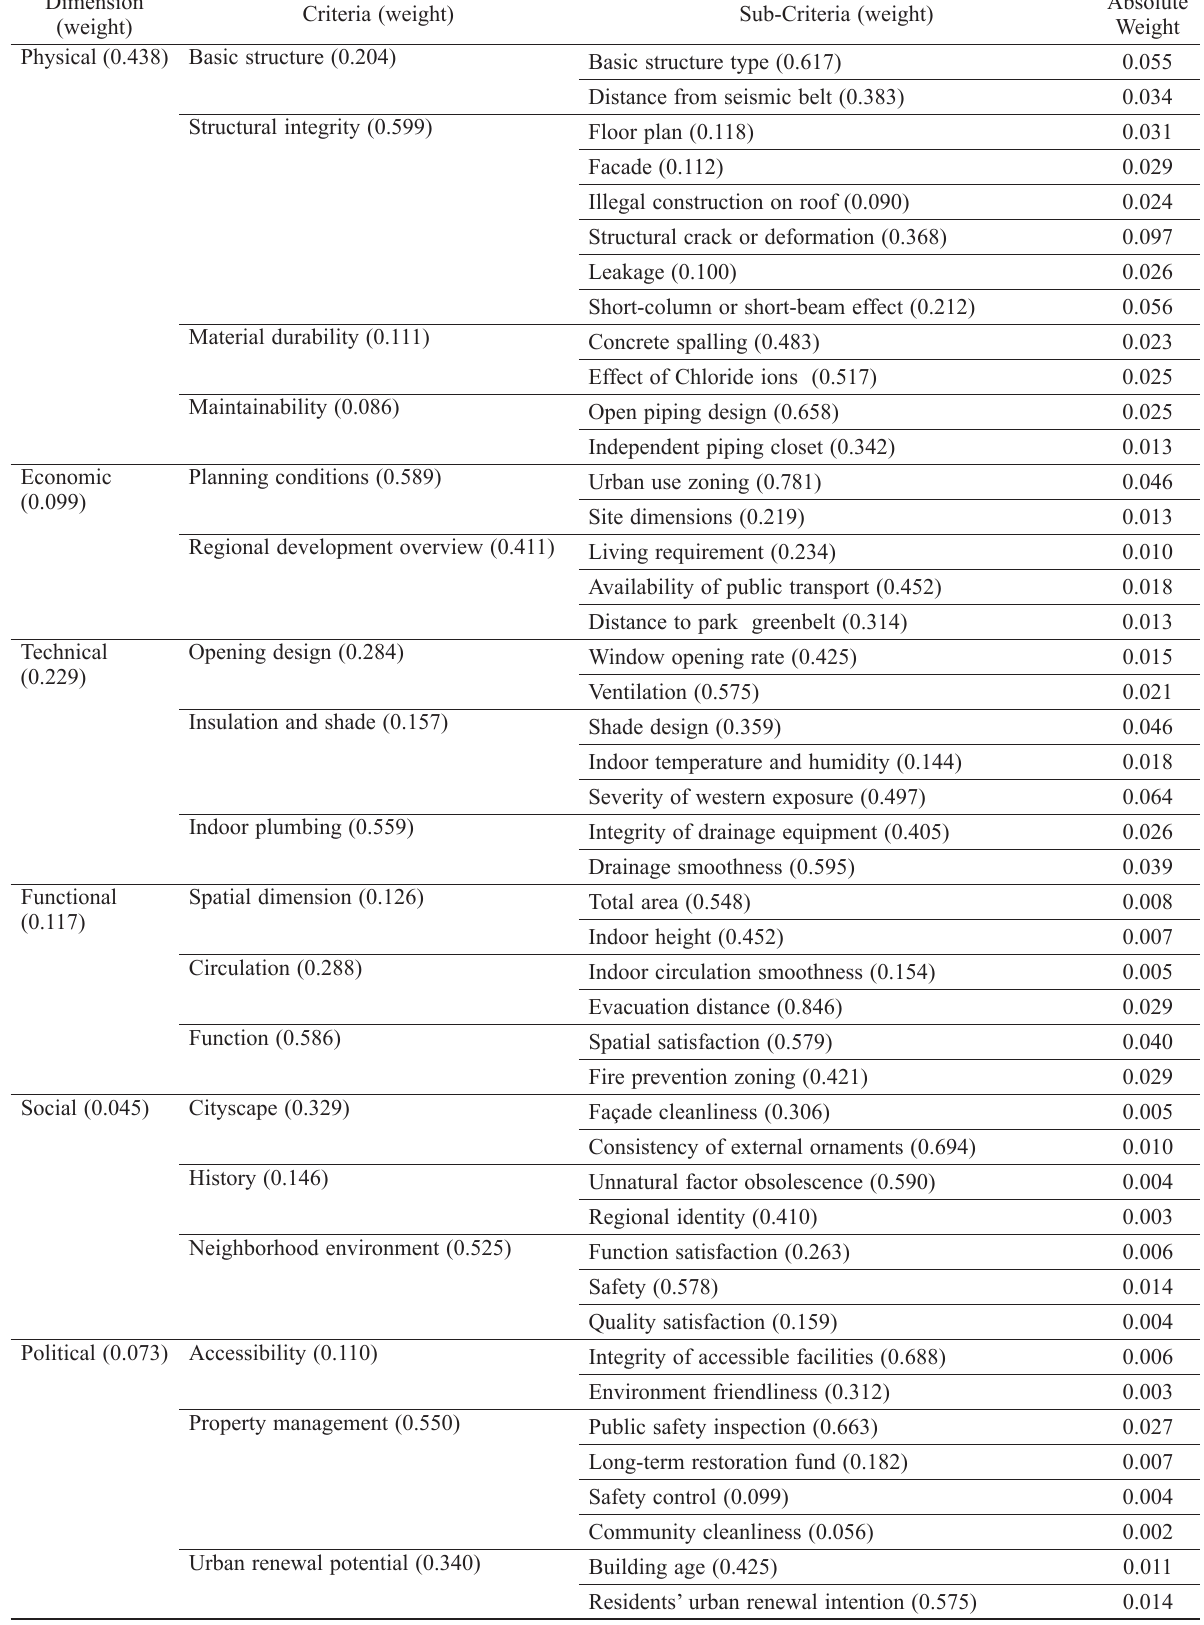
Table 2. Criteria weights for building service